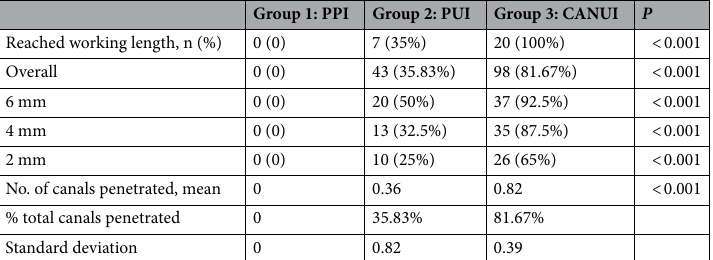
Table 2. Total and percentage of lateral canals penetrated by the irrigation solution in curved root canals.